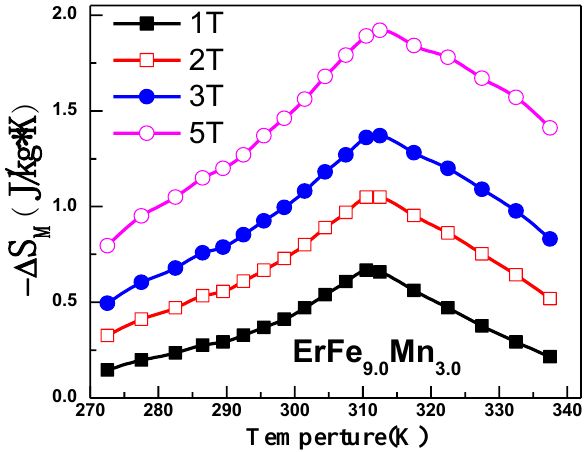
Figure 8. Isothermal magnetic entropy change with temperature for ErFe 9.0 Mn 3.0